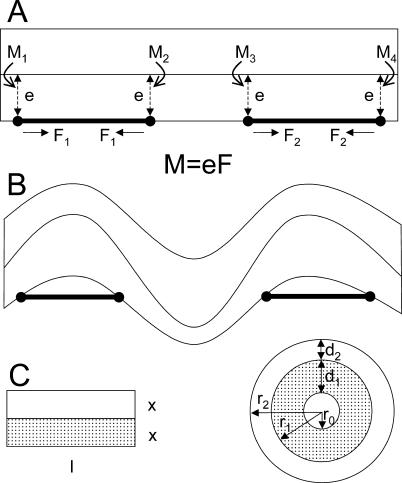
Mechanical Effects in Tissue Folding(A) A simple mechanical model illustrates the deformation of tissue subjected to tangential force (F
1) at an eccentricity (e) from the points of attachment, causing a moment, M. This mechanical deformation is represented by the general relation M = eF.
(B) The moment M causes the sheet to bend in a convex shape. The same principles apply to the second point of connection attachment, subjected to force F
2, resulting in a convexity (gyrus) between connected regions, while a concavity (sulcus) forms between unconnected or weakly connected regions by default.(C) Relative thickness (i.e., the ratio of the thickness of upper to lower cortical layers), changes when a 2-D section of cortical tissue, on the left, is bent into an annulus, on the right. Specifically, the relative thickness of the bent upper layers, d
2, is smaller than that of the lower layers, d
1. A mathematical derivation of these relations is given in Materials and Methods (“Bending a slab of layered neural tissue”).